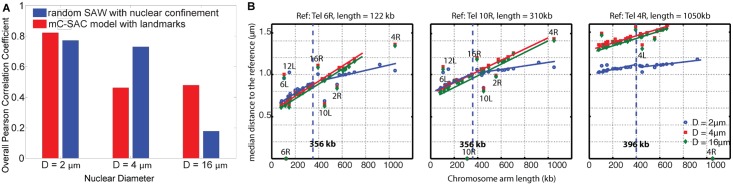
Effects of confinement on the overall folding behavior of budding yeast genome.(A) Overall correlation coefficient of the frequencies between genome-wide 3C measurements and modeled ensemble. As the nuclear size increases, correlation generally decreases. (B) Effects of nuclear size and chromosomal arm length on the median distances between telomeres. Relationships between arm length and median telomere distances at different nuclear sizes for the fully-constrained ensemble, with different telomeres as references are shown. Two linear regimens become one linear regime as D increases from 2 μm to 4 and to 16 μm.